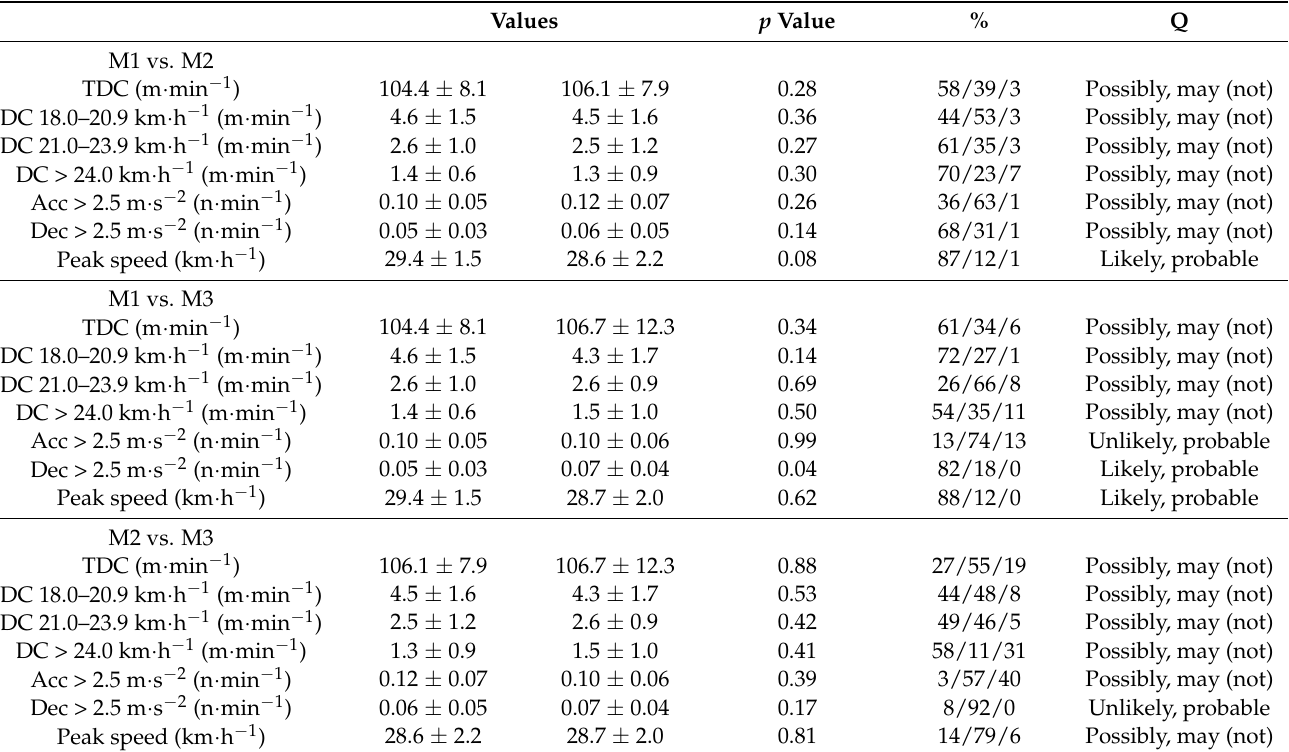
Table 1. External load during the three matches in a congested